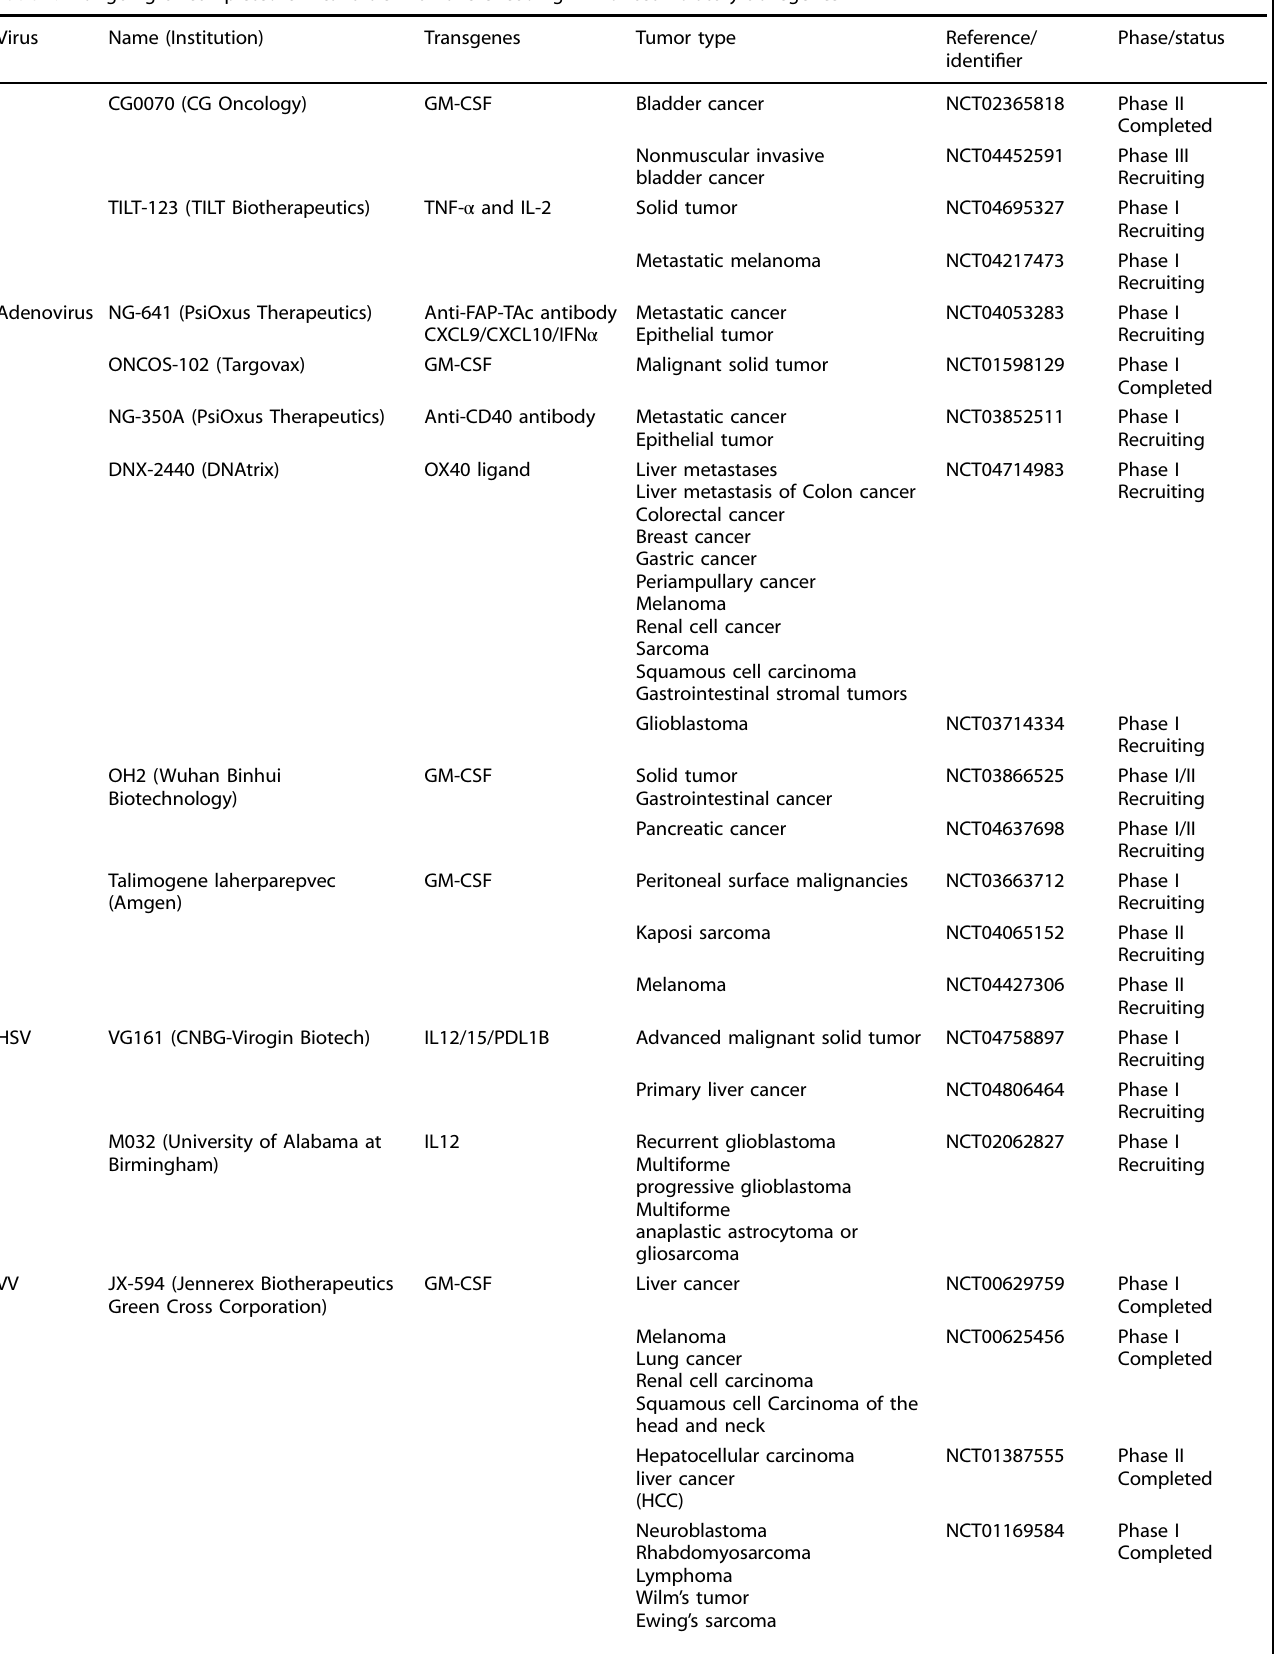
Table 1. Ongoing or completed clinical trials with OVs encoding immunostimulatory